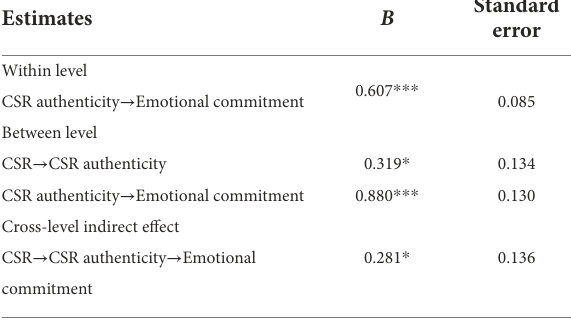
TABLE 8 Multilevel structural equation modeling results (full mediation